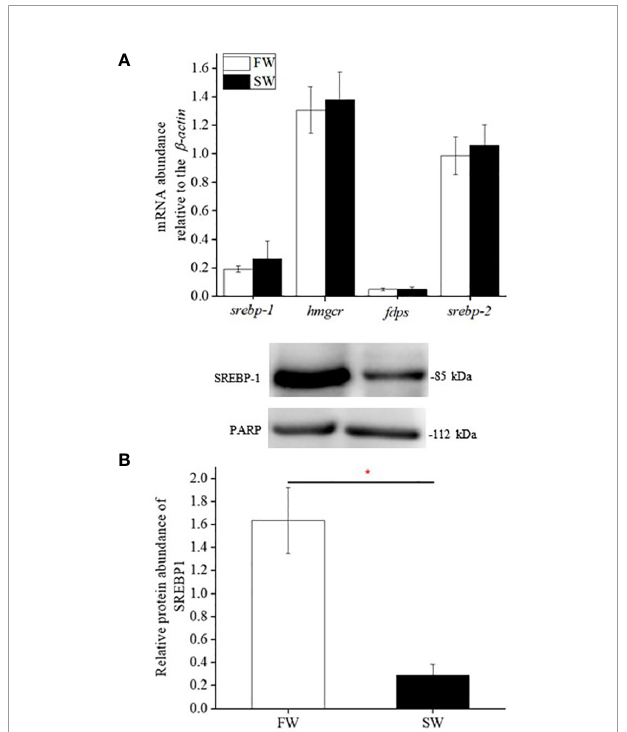
FIGURE 2 | Relative gene (A) and protein (B) expression of SREBP-1, HMGCR, FDPS, and SREBP-2 in livers of fresh water (FW)- and seawater (SW)-acclimated Indian medaka. mRNA expression was analyzed by real-time PCR. The immunoblots were used to detect SREBP-1 protein expression of in the nuclear fractions of livers. Values are mean ± S.E.M. (N = 6). Student ’ s t-test, *p < 0.05.